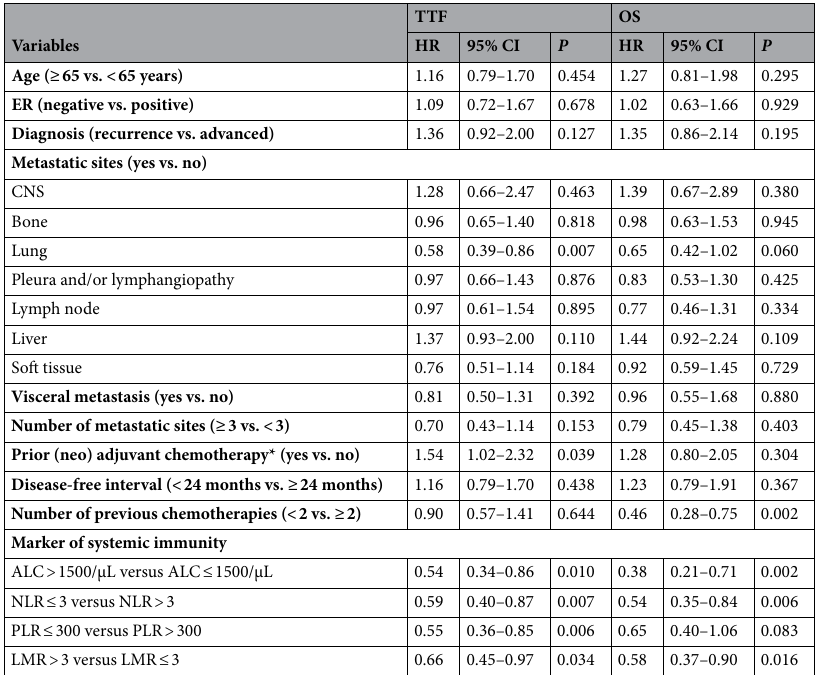
Table 2. Univariable analysis of time to treatment failure and overall survival (Cox hazard model). ALC absolute lymphocyte count, CI confidence interval, CNS central nervous system, ER estrogen receptor, HR hazard ratio, LMR lymphocyte-to-monocyte ratio, NLR neutrophil-to-lymphocyte ratio, OS overall survival, PLR platelet-to-lymphocyte ratio, TTF time to treatment failure. *Chemotherapy included anthracycline and/ or taxane.